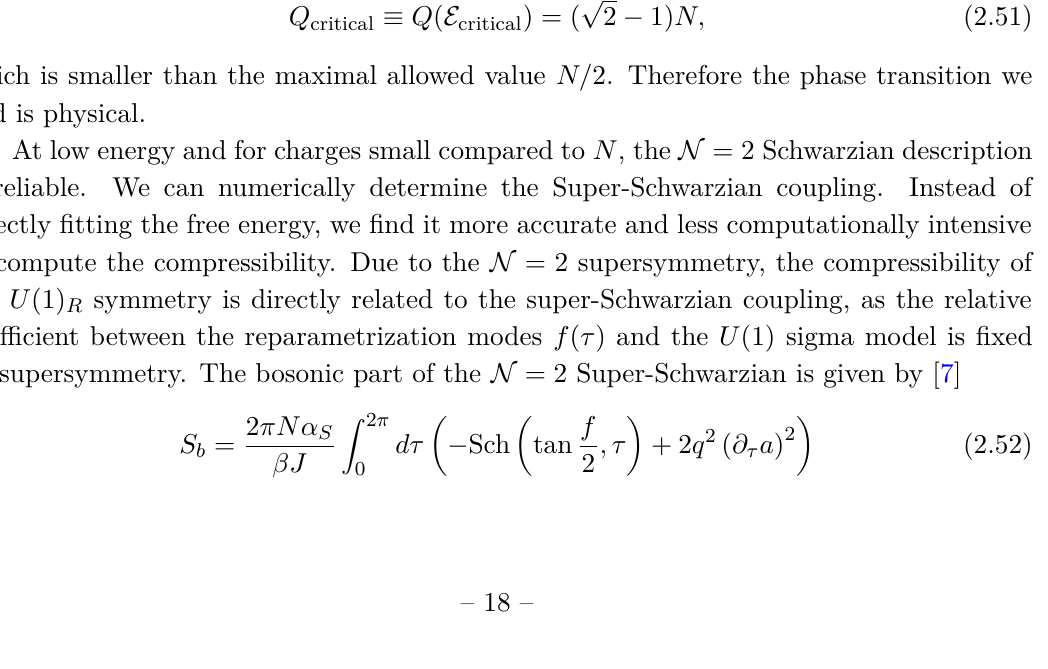
Figure 4 . Plot of g bb /g ψψ computed from the numerical solution for q = 3 at different values of E . Note the infrared Schwinger-Dyson equations can only determine the combination g q − 1 individual values are determined by the full solution. At E = 0 , it agrees with the supersymmetric answer g = 2∆ g = 1 g ψψ bb ψψ 3